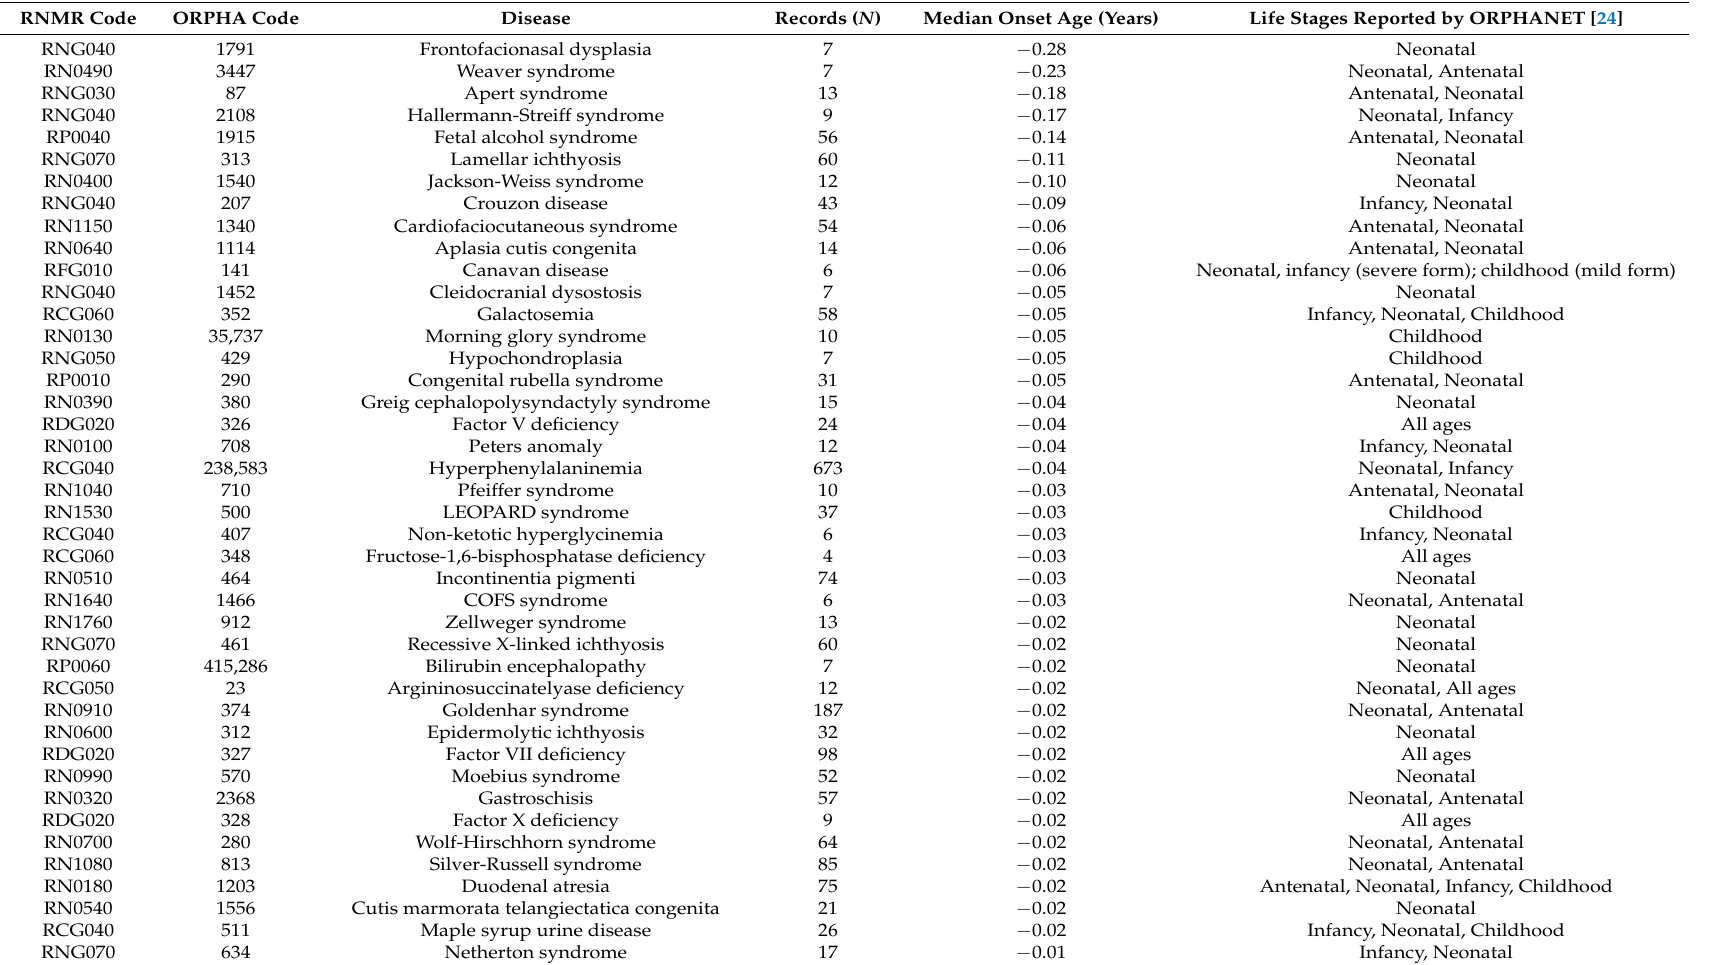
Table 1. Age at symptoms onset of selected rare diseases monitored by RNMR. Dataset: Subset 1; Origin of notifications: all Regions; Record selection: records with diagnosis indicating a specific disease (i.e., excluding disease groups) and at least four records with valid onset date per disease; Total records: 84,859. RNMR